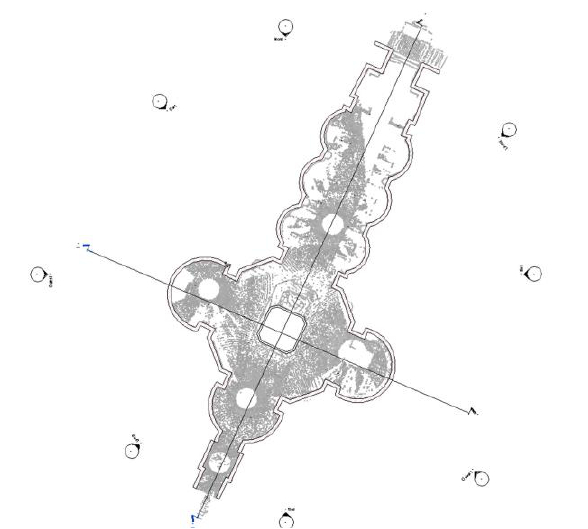
Figure 19. Inserting (up) and 3D rendering (down) of the wall of the Crypt in Revit environment